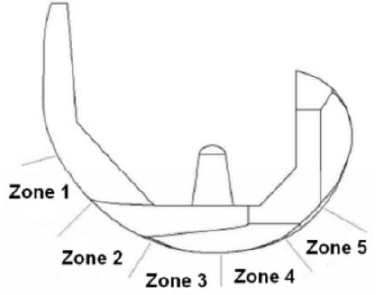
Figure 9. Zones of surface roughness measurement.